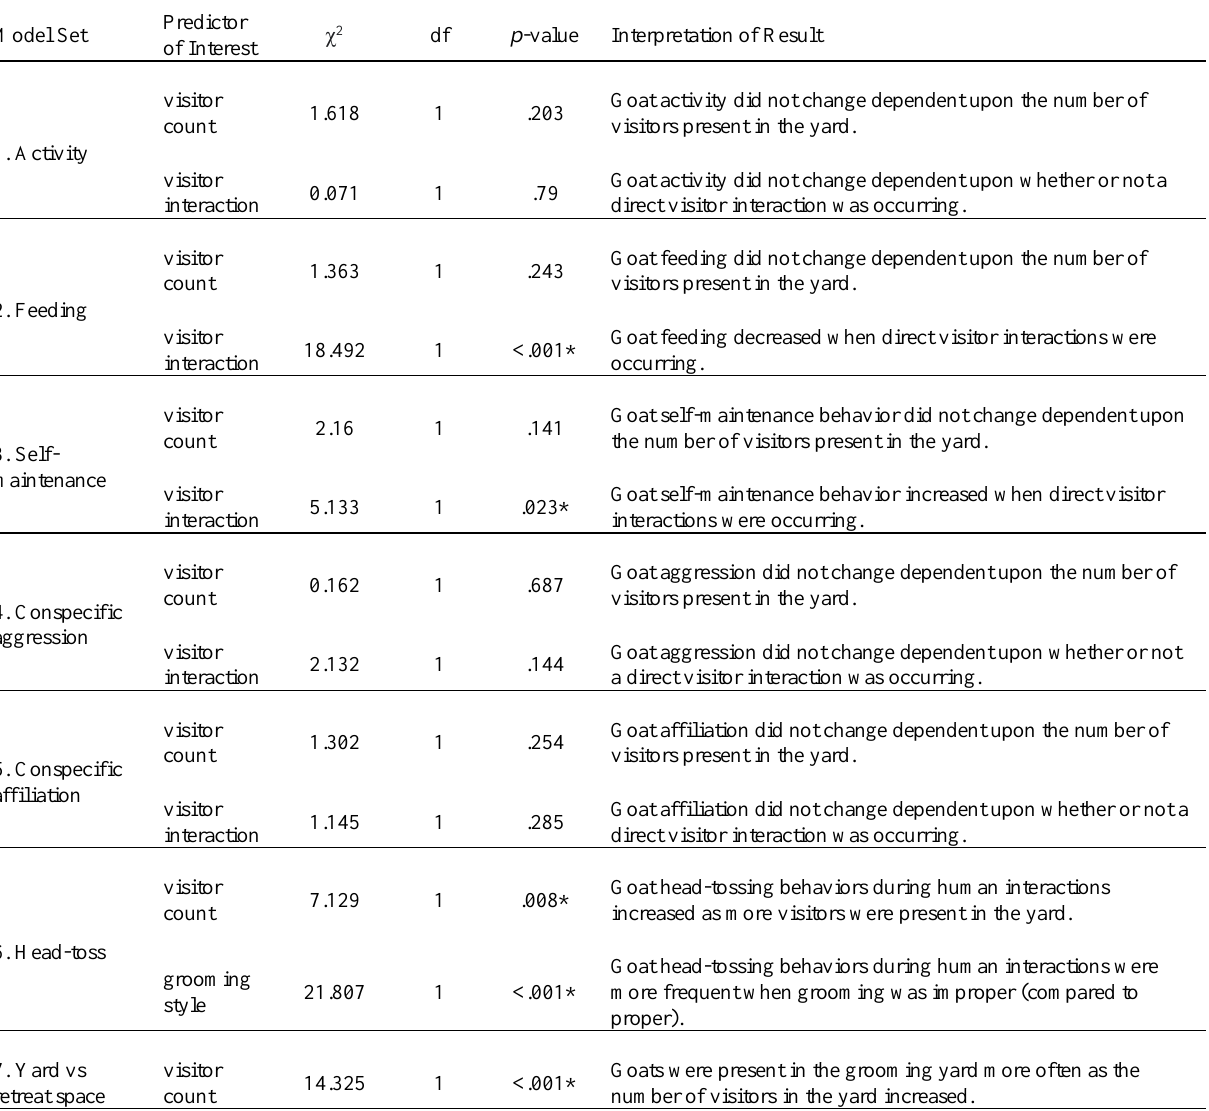
Full-null Model Comparison Results Summary for Binomial Mixed Effects